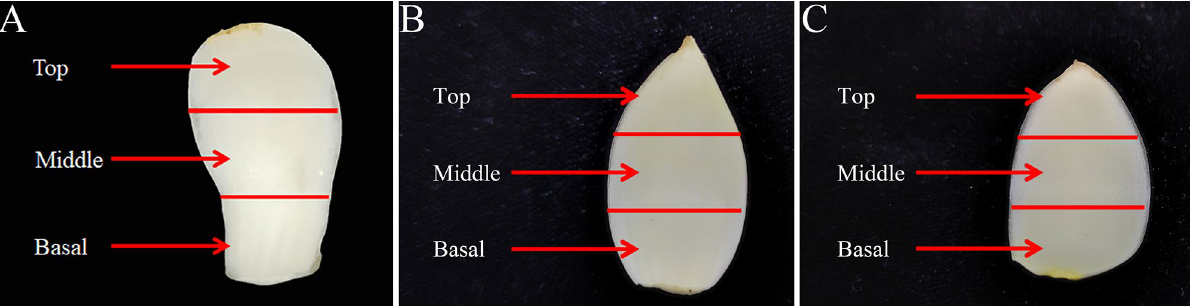
Figure 7. Different layers of bulb scales from different edible lily species used in the study. Different layers of bulb scales from different edible lily species were sorted into three equal parts, named as top part, middle part and basal part. ( A ) Different layers of bulb scales from Lilium davidii var. unicolor ; ( B ) Different layers of bulb scales from Lilium lancifolium Thunb.; ( C ) Different layers of bulb scales from Lilium brownii var. viridulum